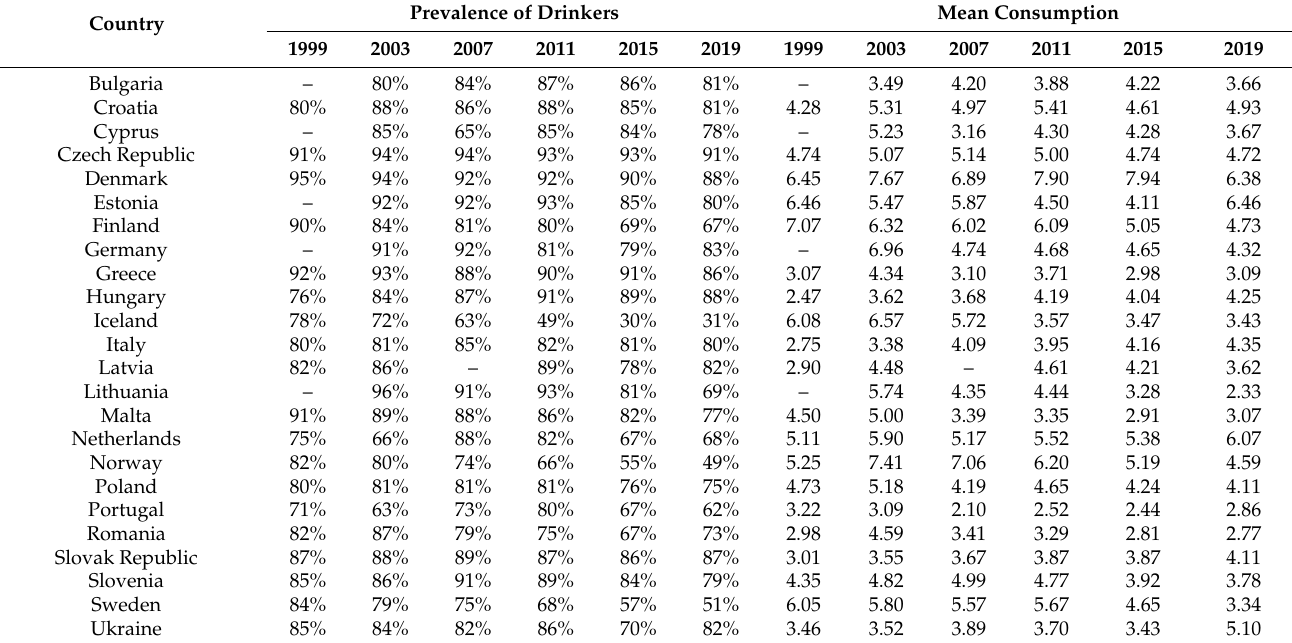
Table A2. Prevalence of drinkers and mean consumption (drinkers only) in pure alcohol (cl) by country and year (1999–2019). Country